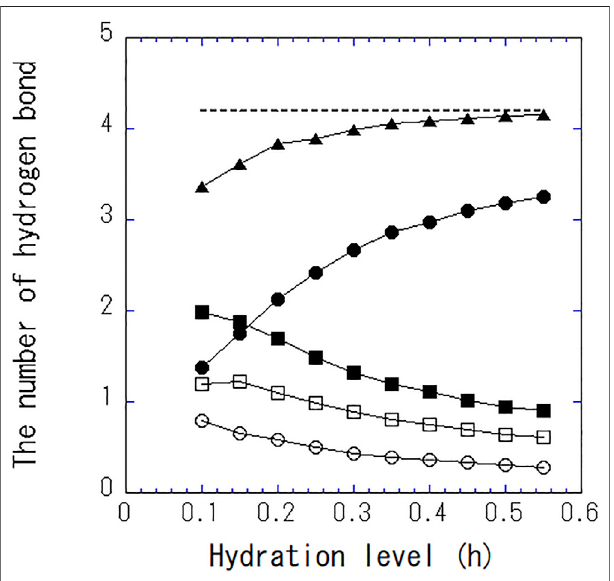
FIGURE 4 | The number of total hydrogen bonds per single water ( ▲ ), between water and water ( C ), between water and protein ( ■ ), between water and the side chain of the amino acid ( □ ), and between water and the main chain of the amino acid ( ○ ). The dashed line indicates the number of hydrogen bond per single water in bulk water.